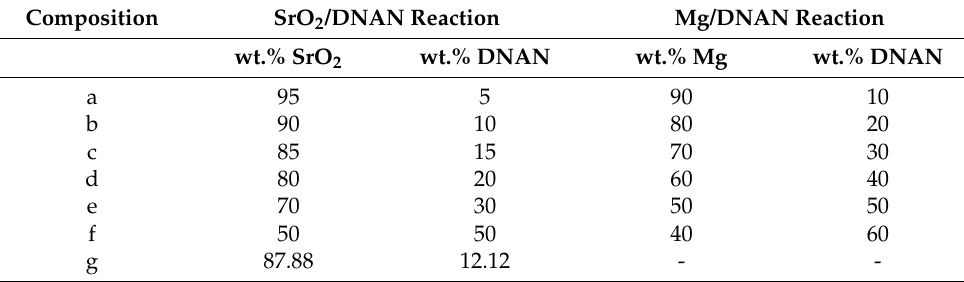
Table 1. Binary compositions